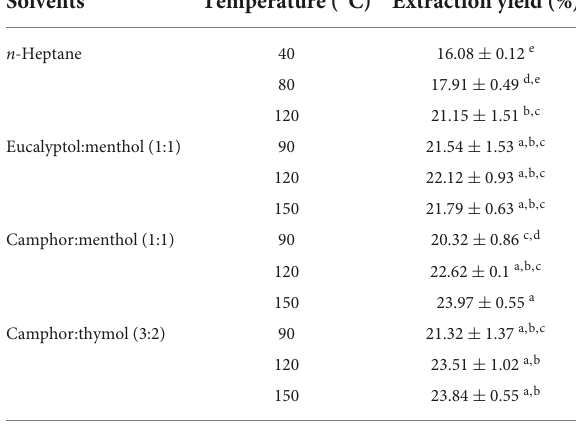
optimize the pressurized conditions to extract the individual TABLE 2 Extraction yield of the defatting process of soybeans employing pressurized liquid extraction (PLE) with n -heptane at 40, 80, and 120 ◦ C and three selected NaHDES candidates, eucalyptol/menthol (1:1), camphor/menthol (1:1), camphor/thymol (3:2), at 90, 120, and 150 ◦